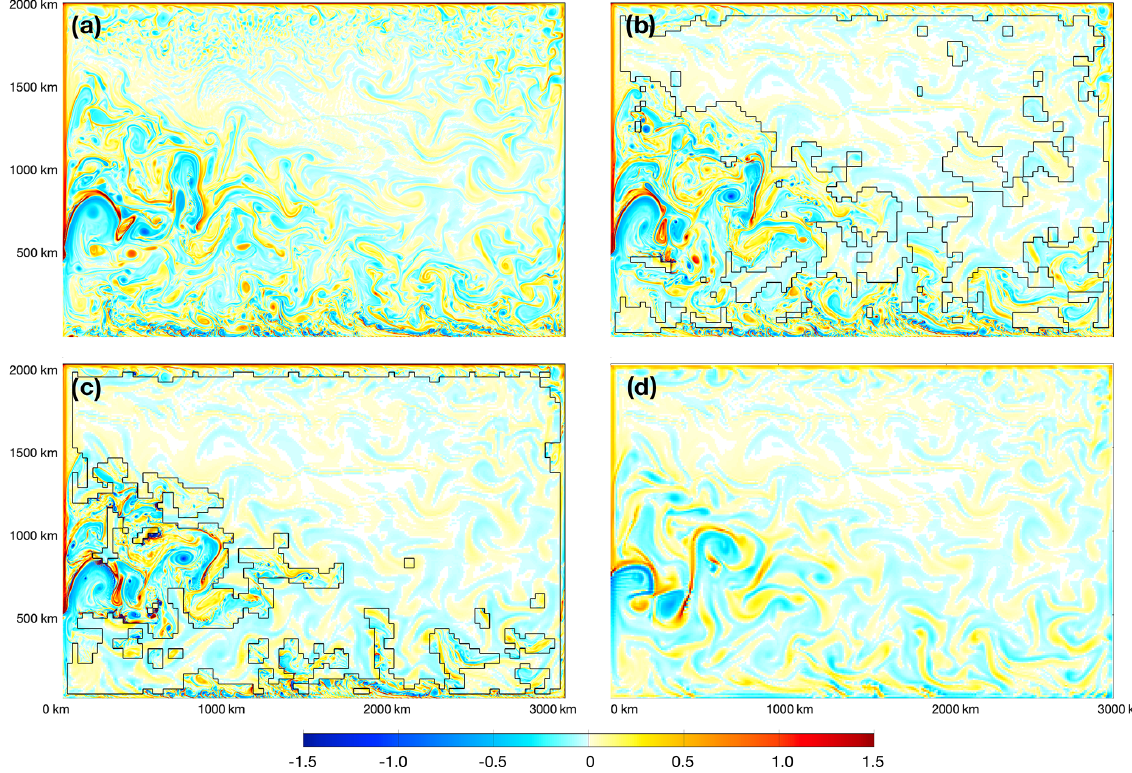
Figure 13. Same as Fig. 10 but for 50d after the refinement since 1